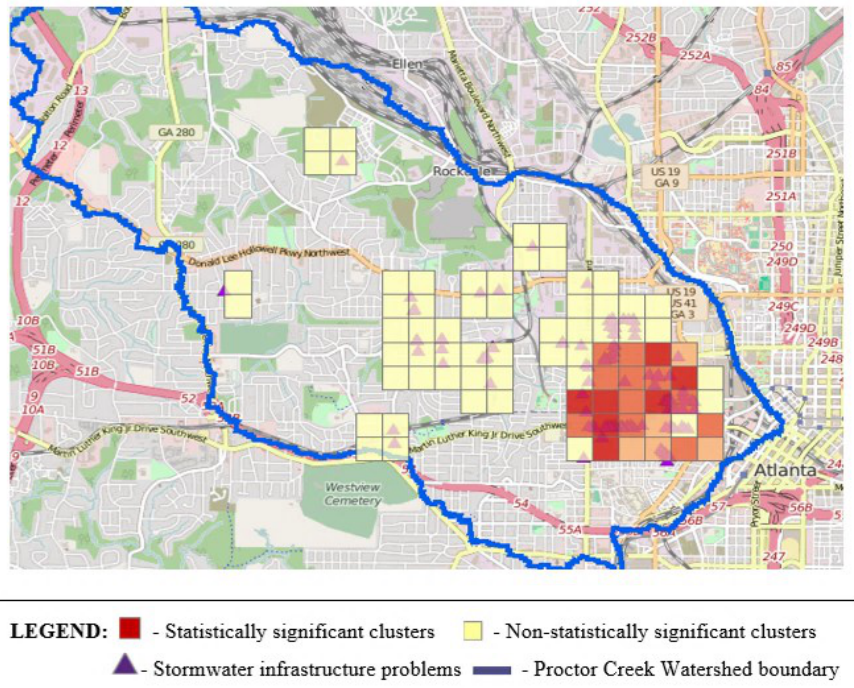
Figure 4. Statistically significant clustering of locations with stormwater infrastructure problems. Int. J. Environ. Res. Public Health 2018 , 15 , x FOR PEER REVIEW